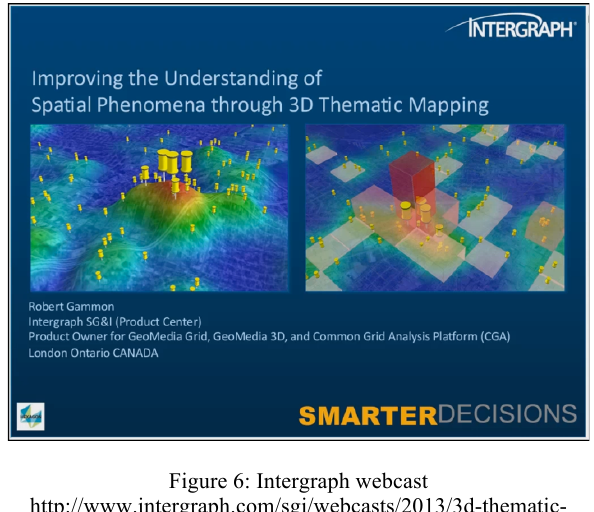
Figure 6: Intergraph